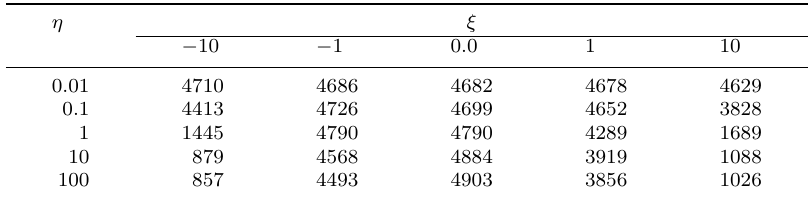
Table 1. The dependence of the number of iterations on the physical parameters ( ξ , η ).